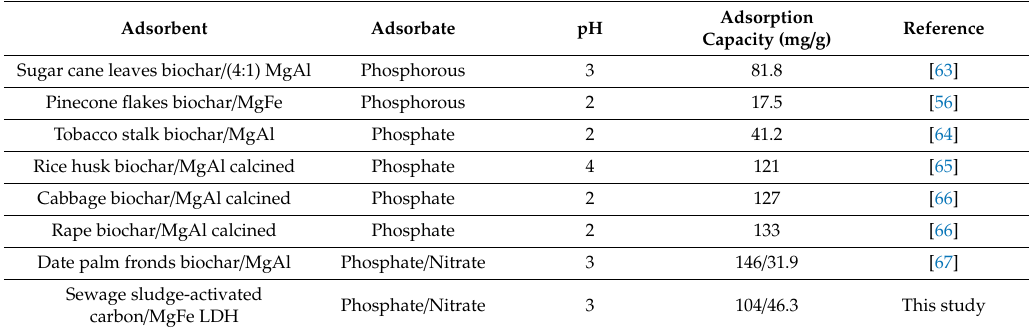
Table 6. Phosphate and nitrate adsorption capacities of various carbon-based layered double hydroxide (LDH)